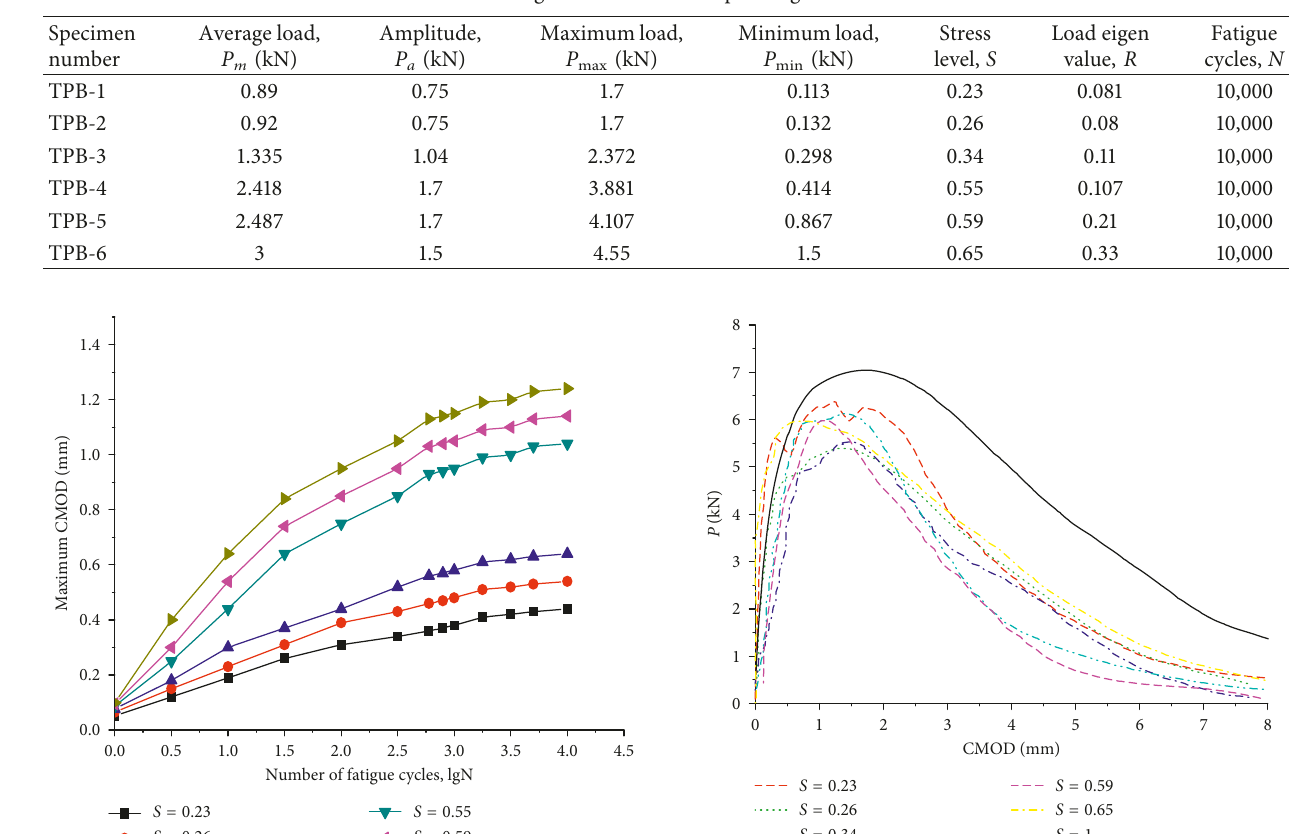
Table 3: Fatigue loads and corresponding stress levels.